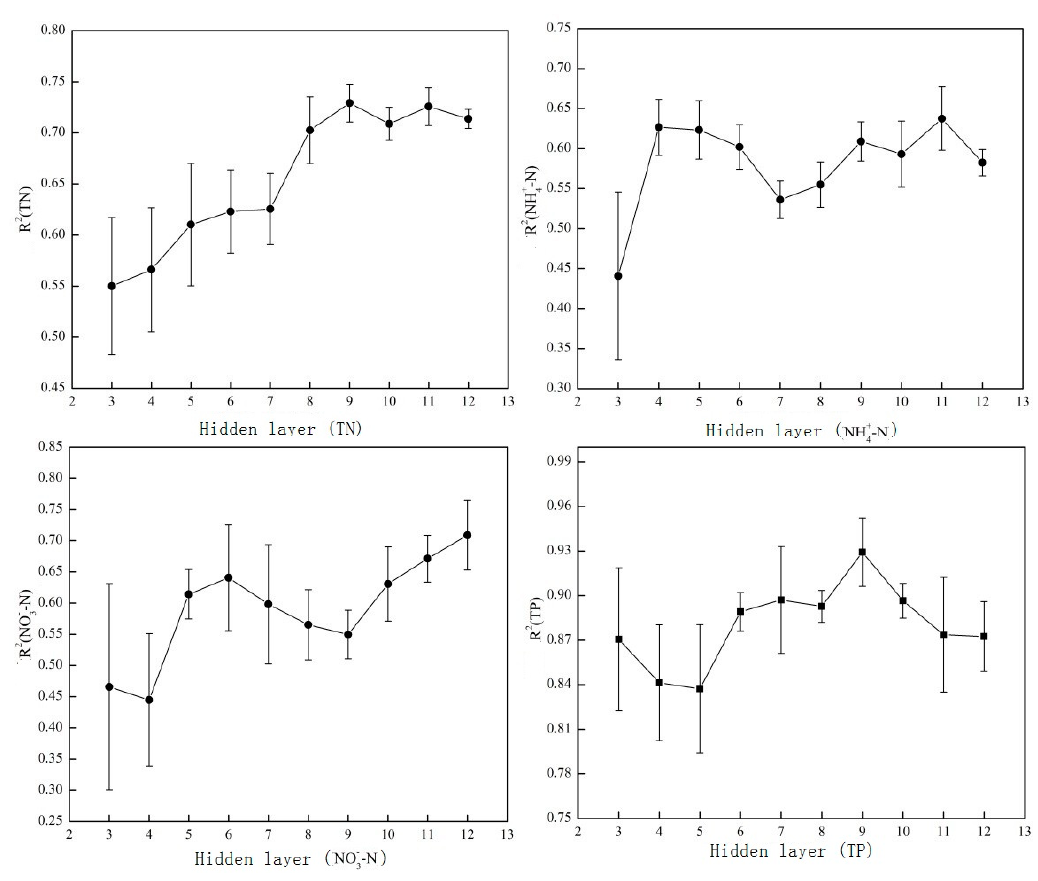
Figure 8. Relationship between the coefficients of determination ( R 2 ) and the number of hidden layers.